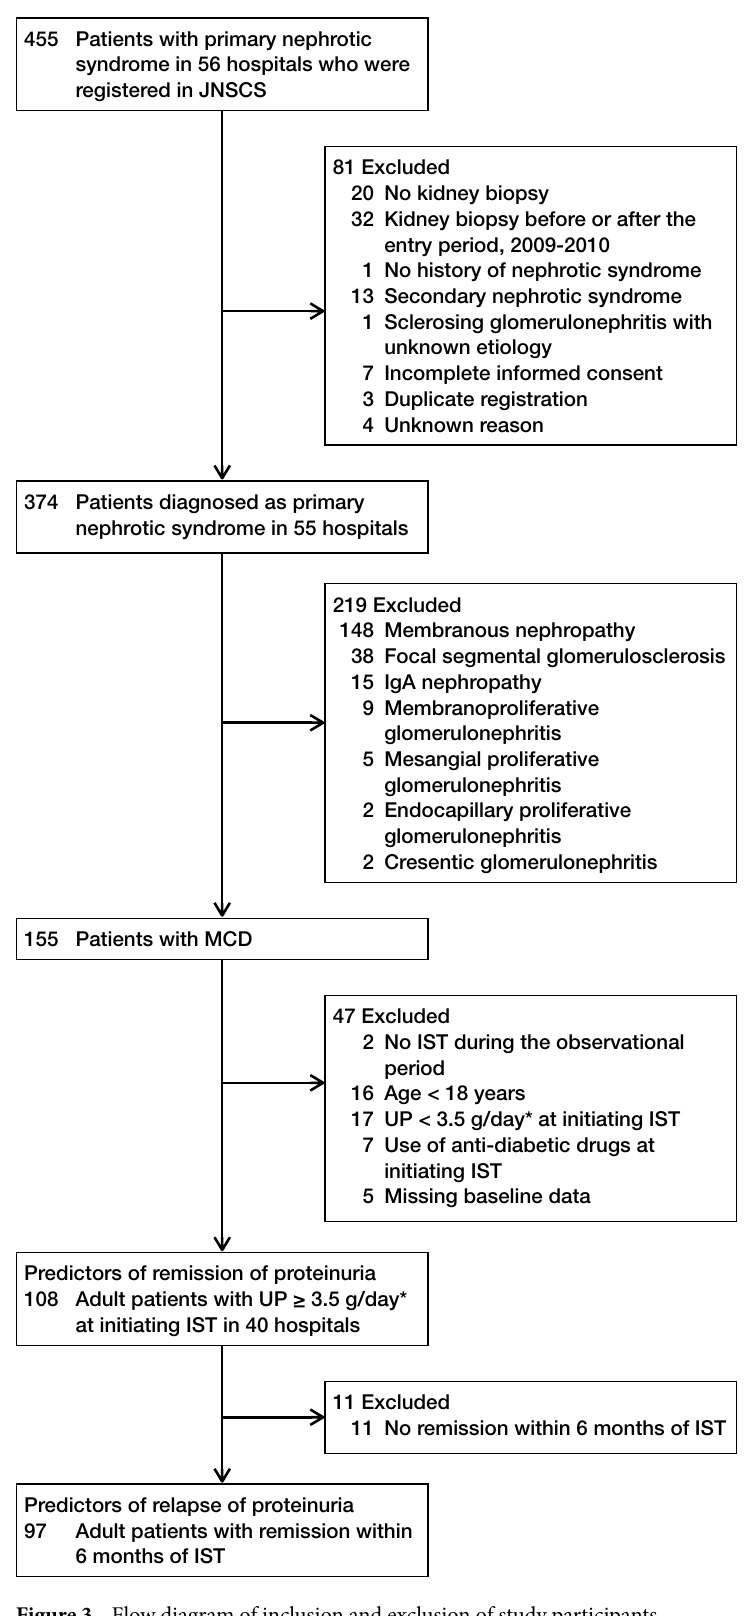
Figure 3. Flow diagram of inclusion and exclusion of study